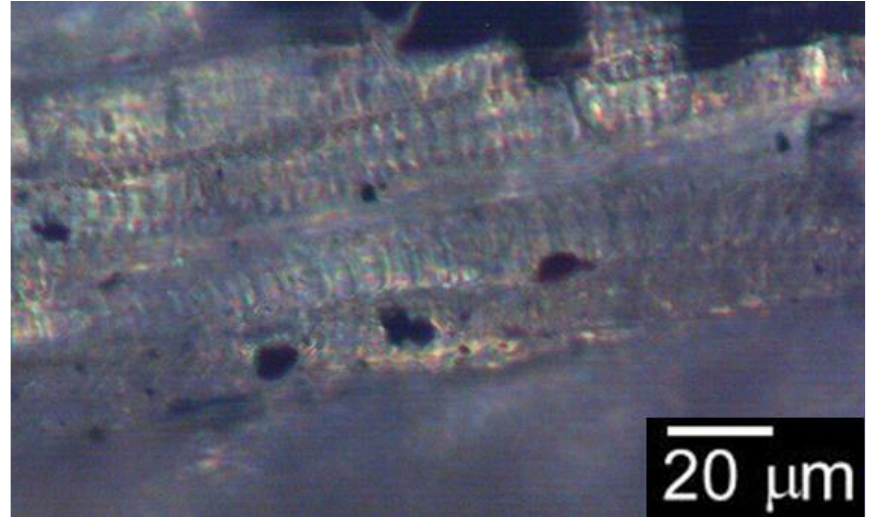
Figure 10. Optical microscopy image of a sprout tissue with PAZ/Hb.